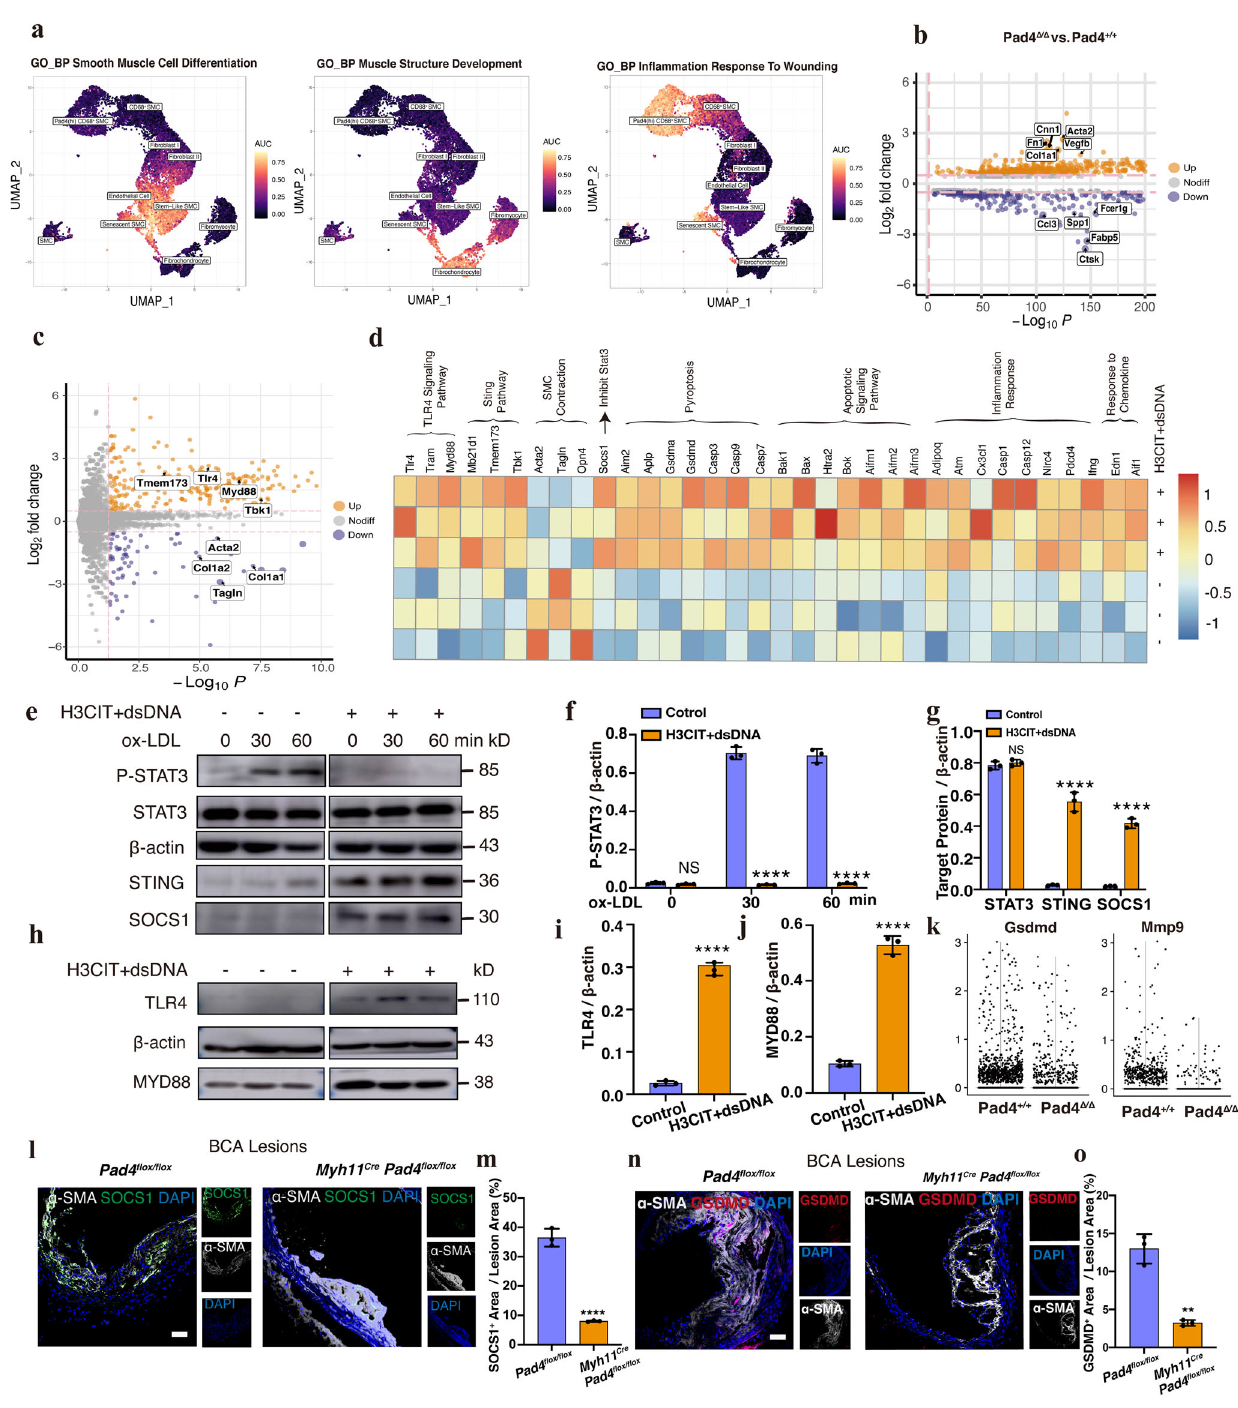
Fig. 5 | PAD4 (hi) CD68 + VSMCs exhibited complex molecular and cellular functions.a Individual cellarea-under-the-curve (AUC) values overlayfor selected differentialcanonicalpathwayactivities. b Volcanoplotsofdifferentiallyexpressed genes (DEGs) were screenedbycomparing Tdtomato + cellsharvestedfrom B6-G/R Myh11 Cre Pad4 fl ox/ fl ox mice ( Pad4 Δ / Δ Tdtomato + cells) with that harvested from B6-G/R Myh11 Cre mice ( Pad4 +/+ Tdtomato + cells) in scRNAseq data. c Volcano plot of DEGs screened by comparing H3CIT+dsDNA challenged rat aortic vascular smooth muscle cells (RASMCs) with control RASMCs of RNA-seq data. d Heatmap showed differentgeneexpressionpatternsbetweengroupsofRASMCsin c . e Westernblot analysis showed RASMCs treated with H3CIT+dsDNA induced a marked decrease in the levels of phosphorylated STAT3, and STING-SOCS1 signaling pathway was activated compared with control RASMCs. f , g The Quanti fi cation of WB results in e ( n =3 independent experiments). Ox-LDL 0h p =0.2067, STAT3 p =0.4199, **** p <0.0001. h Western blot analysis showed RASMCs treated with H3CIT+